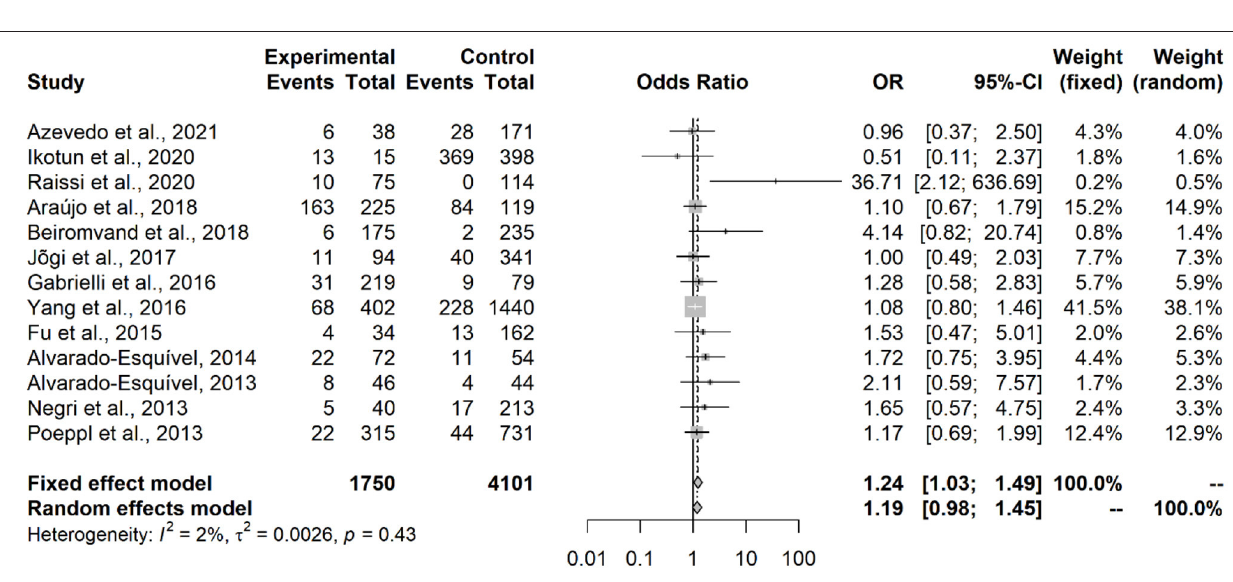
FIGURE 5 | Forest plot for assessment of odds-ratio of influence of contact with cats in the frequency of anti- Toxocara antibodies in adult participants, according to selected articles used in the meta-analysis from 2009 to 2021.